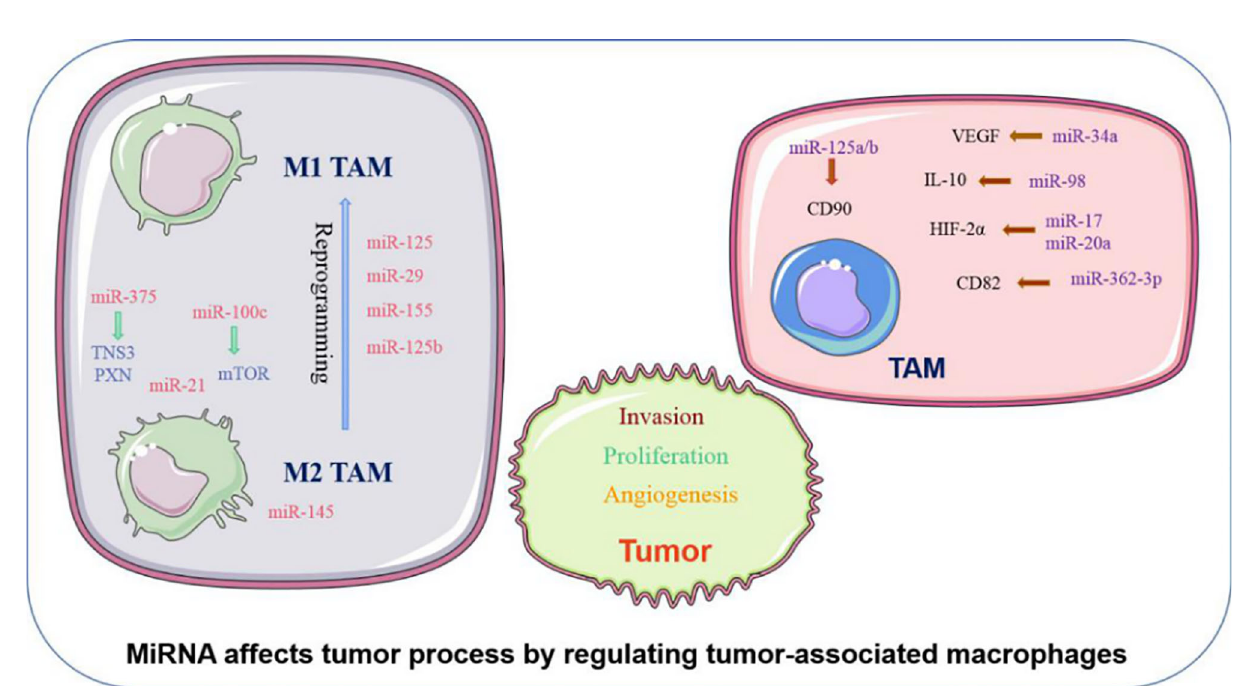
FIGURE 1 | Abnormally expressed MiRNA in TAM can directly regulate its function. M1 and M2 TAM can be controlled by miRNA, which usually promote TAM differentiate into a certain phenotype, making them present M1 or M2 respectively. Certain M2 TAMs also undergo reprogramming after being affected by miRNA, causing to lost their tumor-promoting